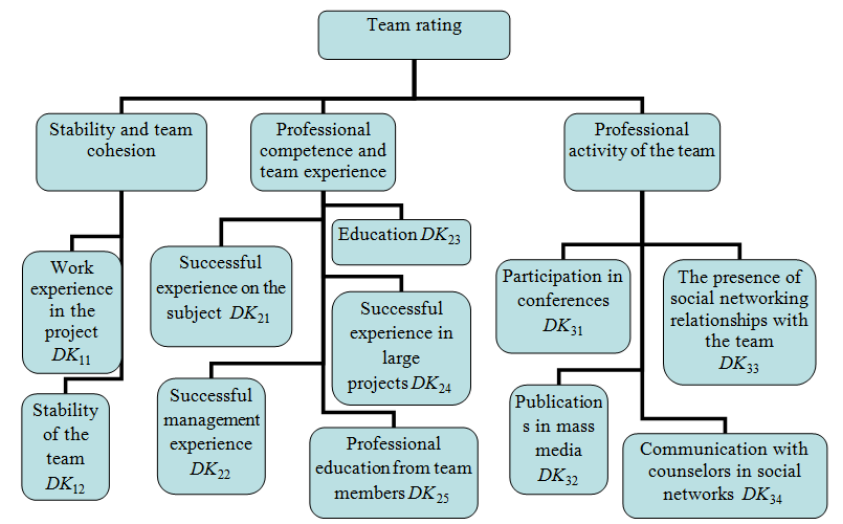
Figure 1. Scheme of evaluation criteria for teams of developers of environmental start-up projects.